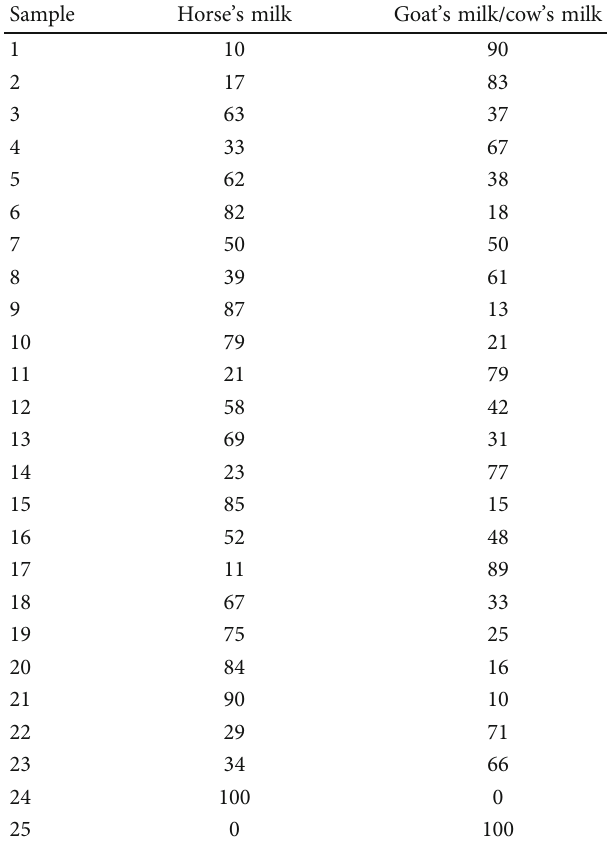
Table 1: The binary mixture of samples containing horse ’ s milk and goat ’ s milk/cow ’ s